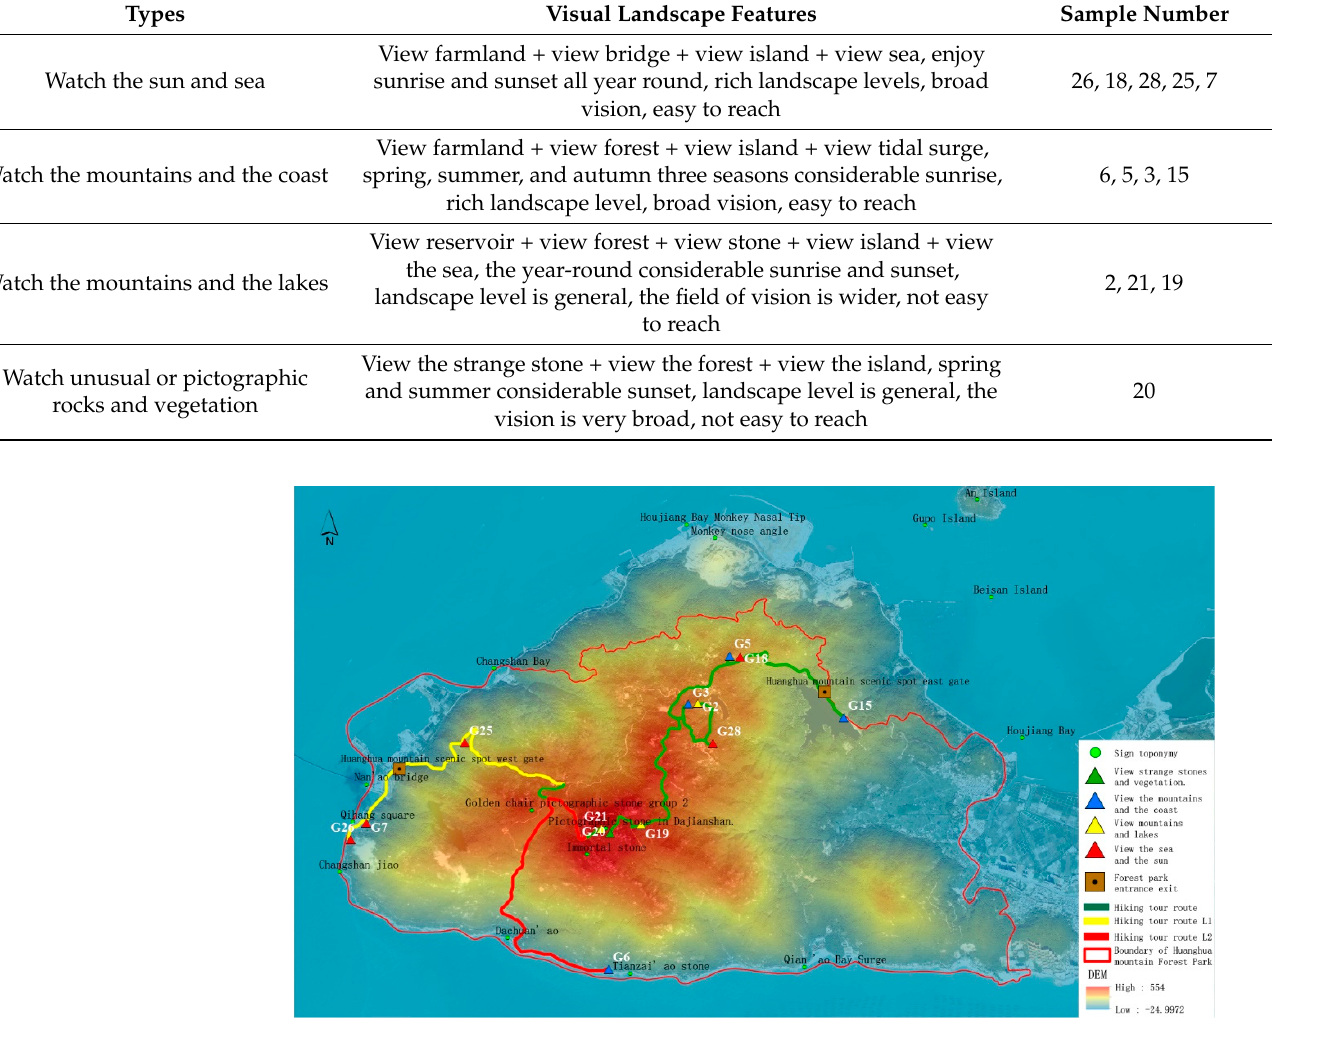
Figure 8. Walking tour route in Huanghua Mountain scenic area.